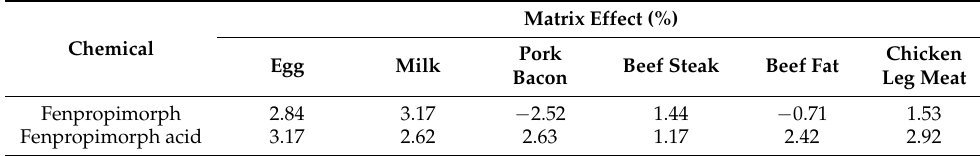
Table 3. Matrix effects of the livestock matrices on the calibration of the target chemicals.